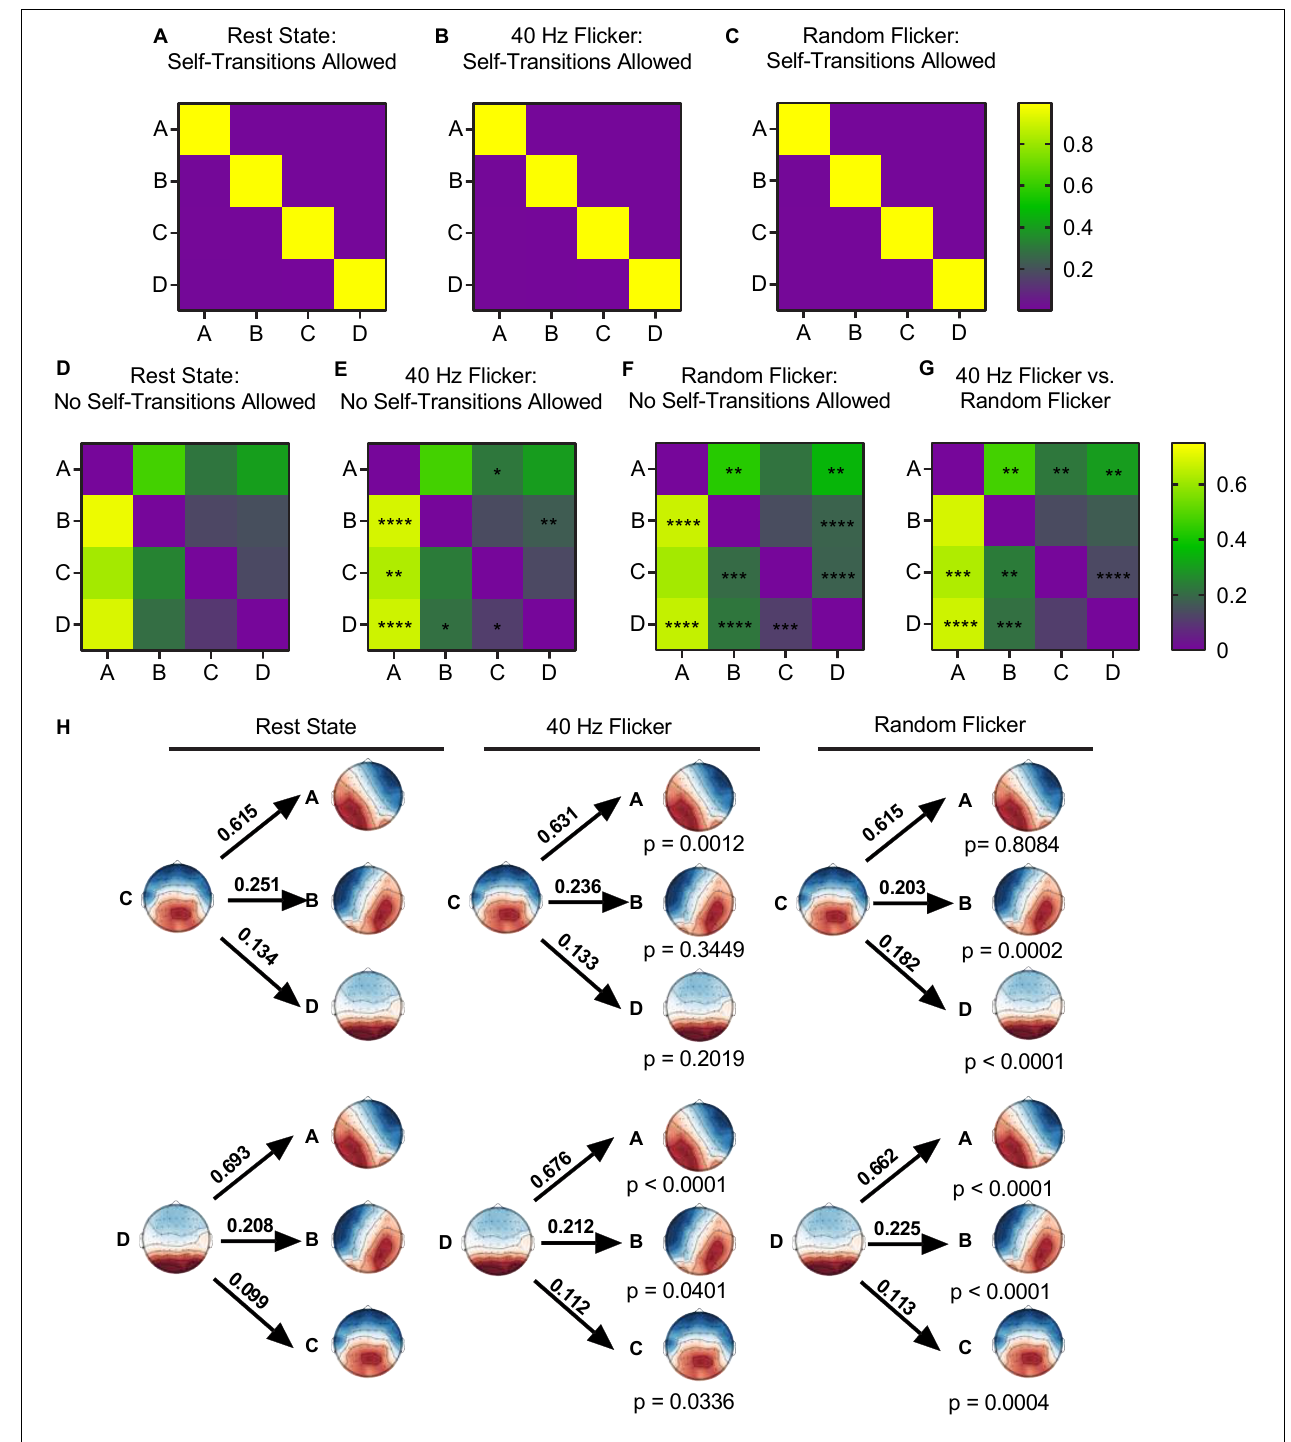
FIGURE 4 | Microstate transition syntax analysis in different conditions. Panels (A–G), each map displays Markov chain analysis result for one of the four microstate classes. (A–C) Self-transition allowed tests, and (D–G) for self-transition not allowed tests. Panel (H) shows a schematic view of the syntax pattern to indicate transition from C and D to other states in the rest state (left), 40 Hz flicker (middle), and random flicker (right). A one-way ANOVA with Tukey post hoc multiple comparison test was used to identify significant groups. *, **, ***, and **** indicated the Tukey adjusted P < 0.05, P < 0.01, P < 0.001, and P < 0.0001, respectively. Scale bars represent the probability